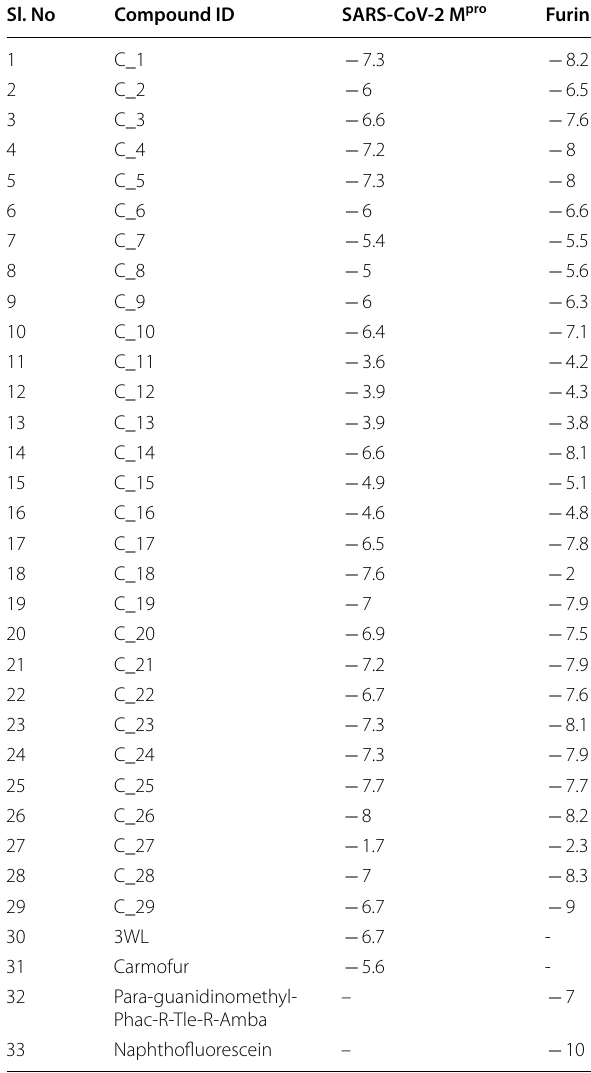
Table 2 Binding affinities (kcal/mol) of the phytocompounds towards SARS-CoV-2 M pro and furin Sl.